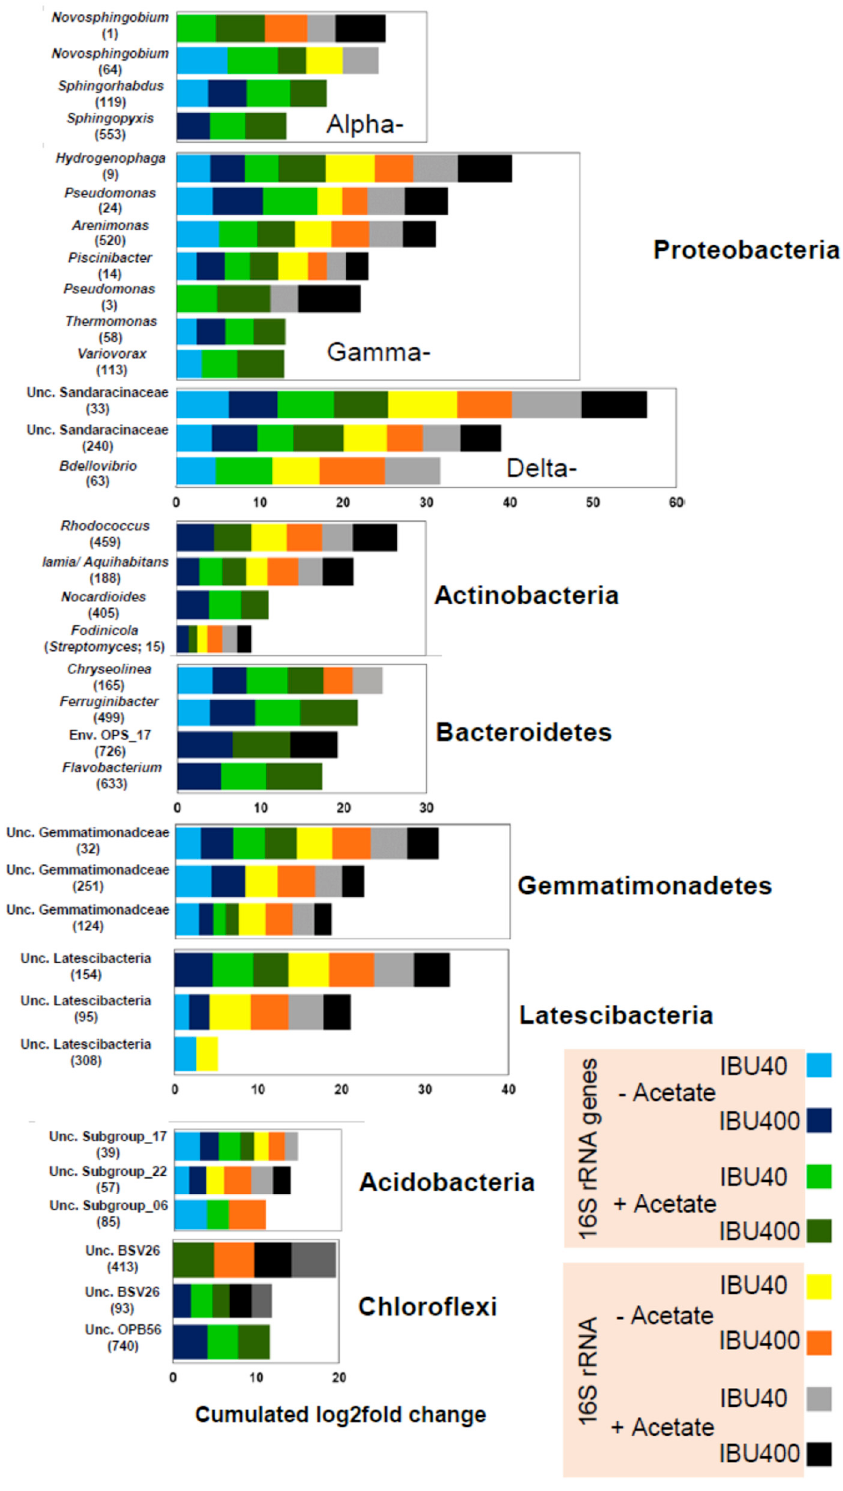
Figure 4. Log2fold change of ibuprofen-responsive OTUs summed up for all OTUs affiliating with the same (sub-) phylum (based on data from Table S2). A, DNA; B, RNA (cDNA). OTUs significantly enriched by ibuprofen relative to unamended controls sampled at the same time point had a Log2-fold change > 0 at p -adj < 0.05. IBU40 and IBU400, ibuprofen amendment with 40 and 400 µ M ibuprofen, respectively. IBA40 and IBA400, ibuprofen amendment with 40 and 400 µ M ibuprofen, respectively, together with 1 mM acetate.